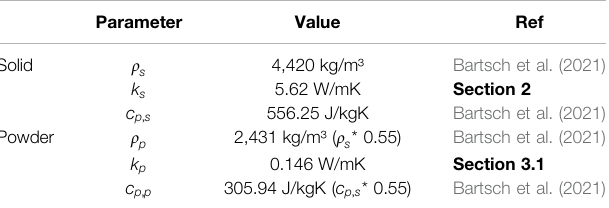
TABLE 2 | Material model of Ti-6Al-4V used in